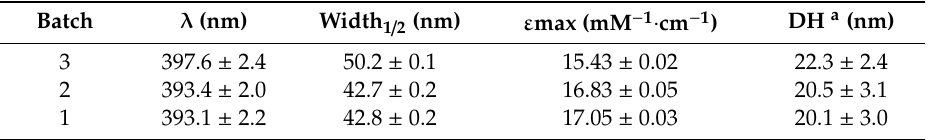
Table 3. Wavelength values ( λ ) of the plasmon maximum, width of the peak at half the maximum, extinction coe ffi cient ( ε max) obtained by UV-Vis spectroscopy and hydrodynamic diameter (DH) by DLS for three di ff erent commercial batches of